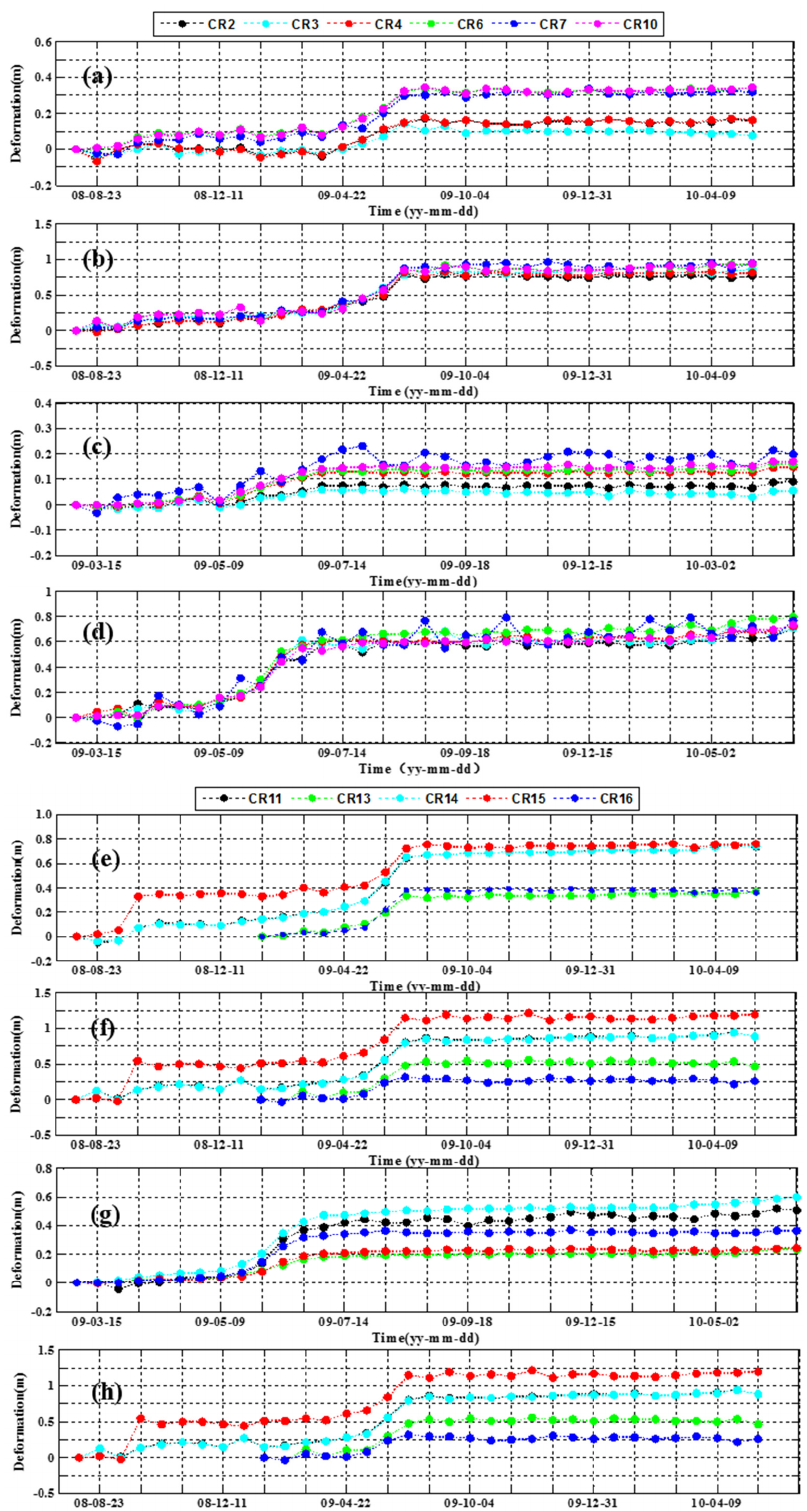
Figure 9. Time-series displacement of corner reflectors in Groups 2 and 3. ( a – d ) are displacement at CRs in Group 2; ( a , b ) are displacement in range and azimuth using SM stack; ( c , d ) are displacement in range and azimuth using HS stack; ( e – h ) are displacement at CRs in Group 3; ( e , f ) are displacement in range and azimuth using SM stack; ( g , h ) are displacement in range and azimuth using HS